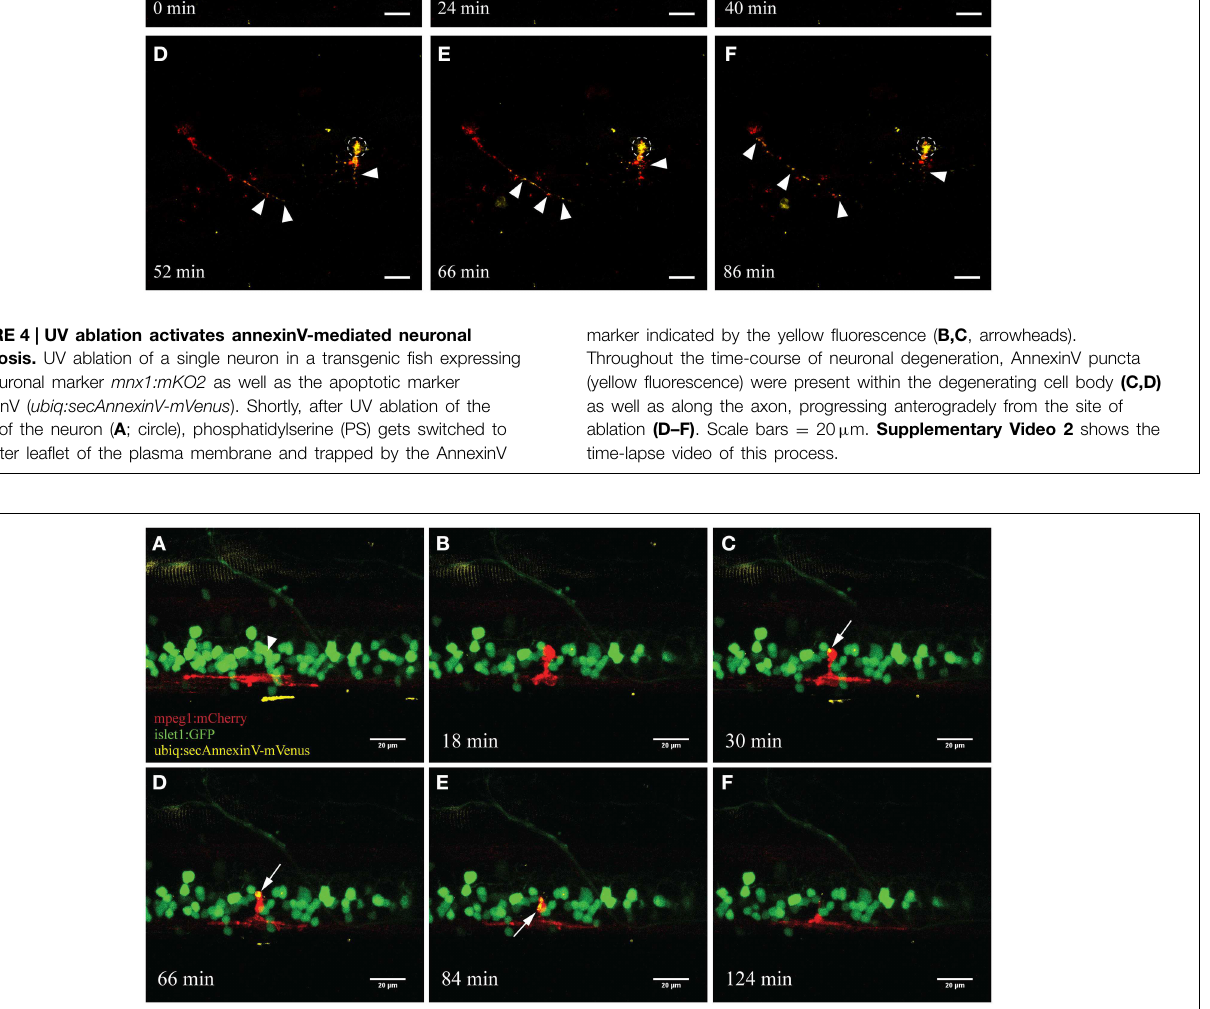
FIGURE 5 | Accumulation of the apoptotic marker AnnexinV within microglia. Upon ablation of a neuron in the spinal cord ( A ; arrowhead) the surrounding microglia moved toward the ablation site (B) . After several minutes the fluorescently labeled marker AnnexinV lights up within the microglia ( C ; arrow). AnnexinV accumulation within